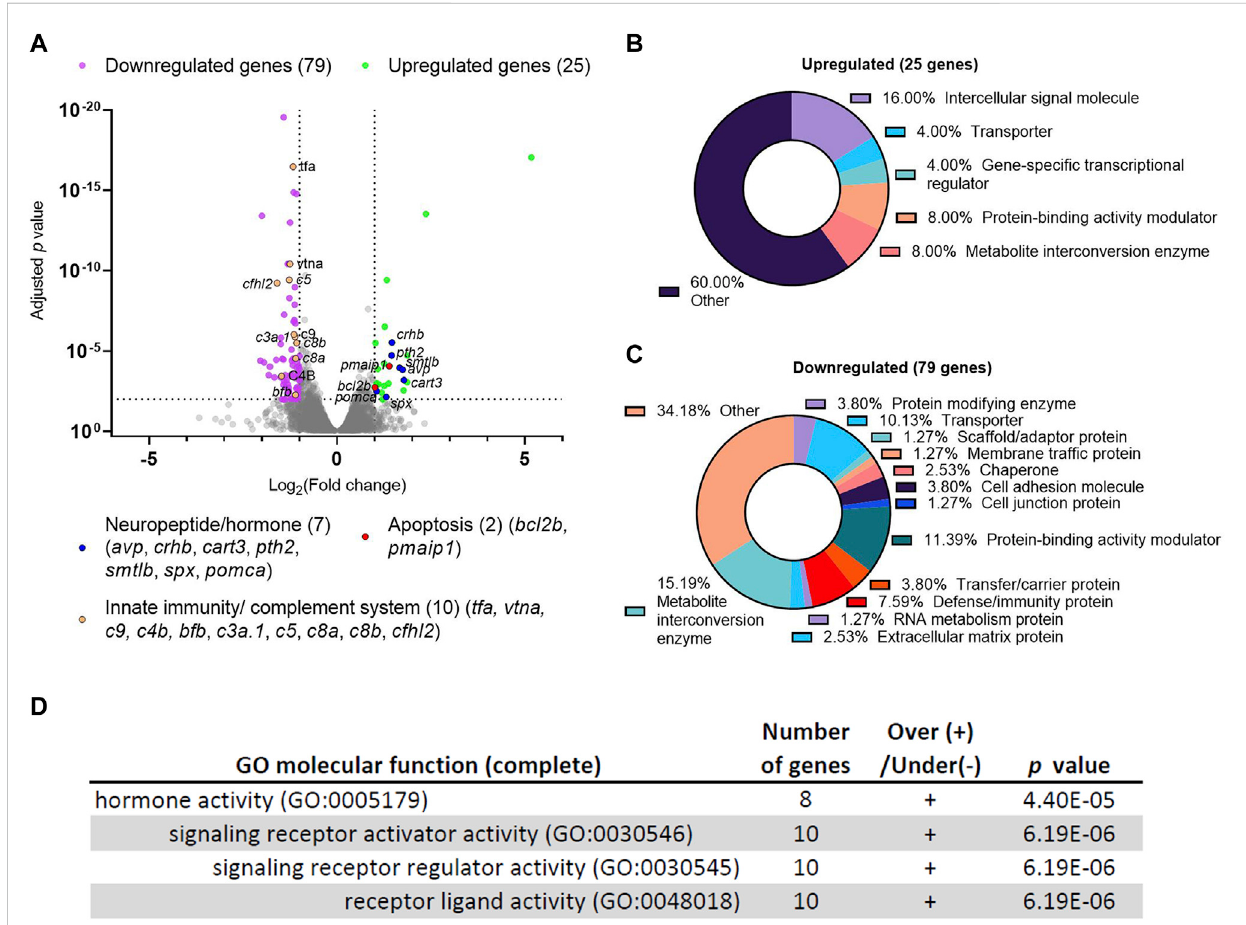
Differential gene expression analysis of dscaml1 de fi cient zebra fi sh. (A) Volcano plot of relative gene expression in dscaml1 − / − versus control animals. Each dot represents an individual gene, with colored dots representing gene groups as indicated on the graph. The dotted lines show the signi fi cancelevel(adjusted p < 0.01)andfoldchange(increaseordecreasebytwo-foldormore)thresholds (B,C) Proteinclasscategorizationanalysisfor upregulated (B) and downregulated (C) genes. (D) Table of signi fi cantly enriched ( p < 0.05 ) GO terms for molecular